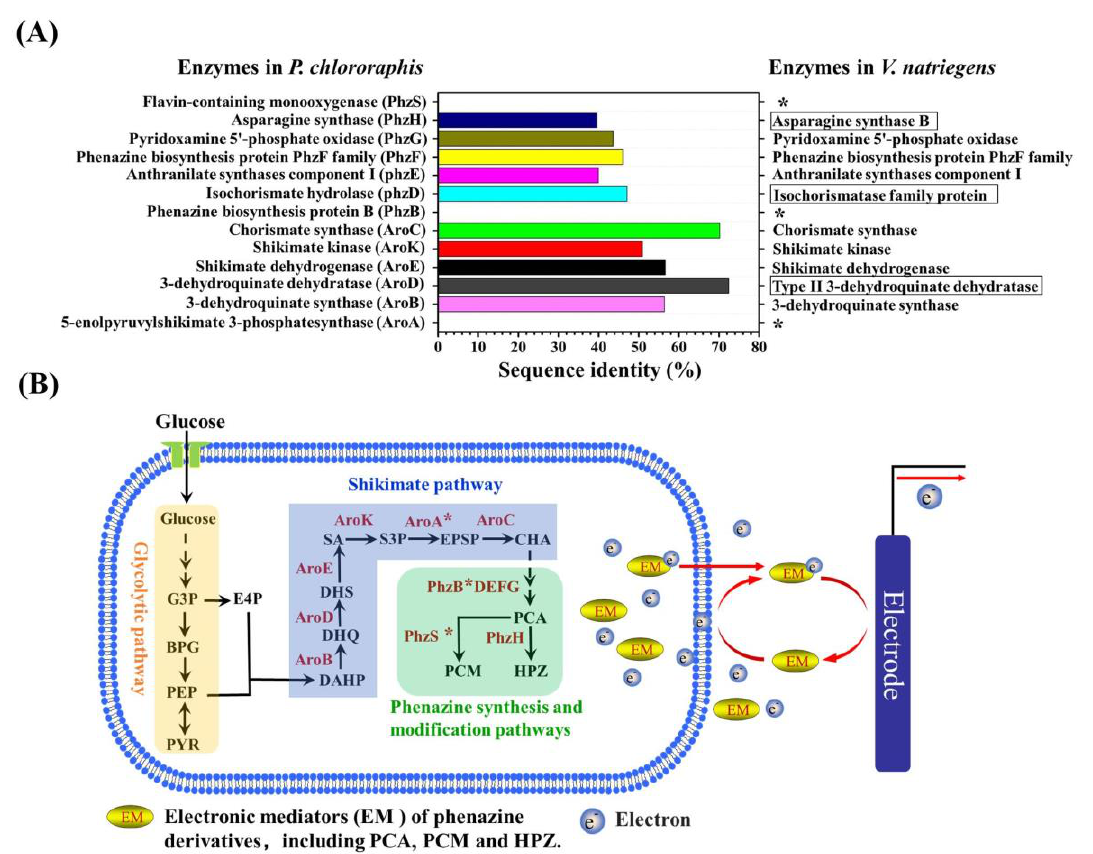
Figure 7. Protein sequence alignment and an identified biosynthesis pathway of phenazine deriva- tives electron mediators in V. natriegens . ( A ) Protein sequence alignment of phenazine derivatives electron mediators in V. natriegens by using the reported protein sequences of phenazine derivatives from P. chlororaphis and BLAST . Left axis: the names of enzymes reported in P. chlororaphis for the biosynthesis of phenazine derivatives; right axis: the names of enzymes identified in V. natriegens by BLAST. The mark of “*” denotes that the corresponding enzyme is not found in V. natriegens by protein sequences alignment. These enzymes in the rectangular box indicate that their names marked in the protein sequences of V. natriegens are different from that in P. chlororaphis . ( B ) The identified biosynthesis pathway of phenazine derivatives electron mediators in V. natriegens based on the LC-MS/MS characterization and protein–protein sequence alignment, as well as previous reports. G3P: glyceraldehde-3-phosphate; BPG: 1,3-bisphosphoglycerate; PEP: phosphoenolpyruvate;